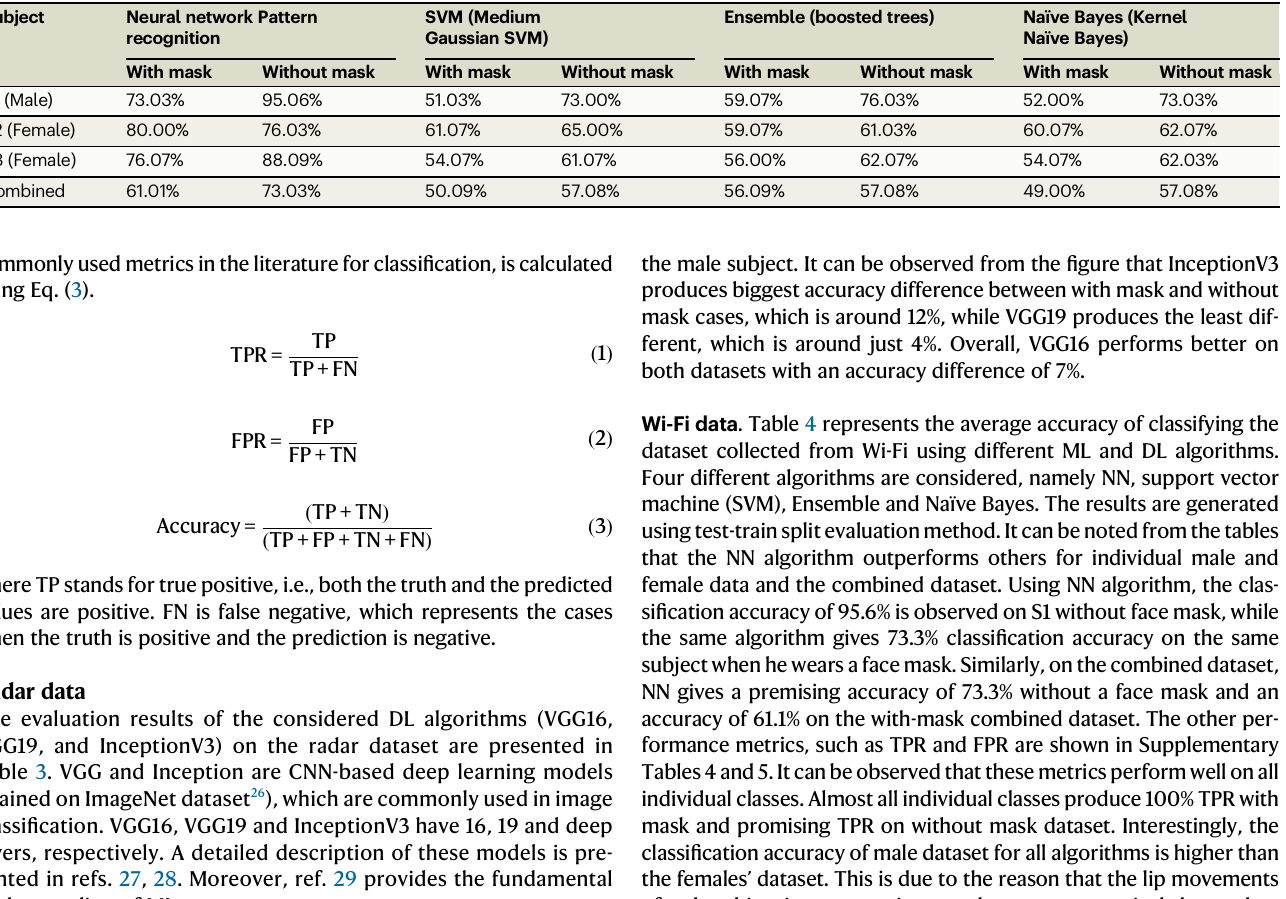
Table 4 | Comparison between different ML and DL algorithms in classifying vowels on the Wi-Fi